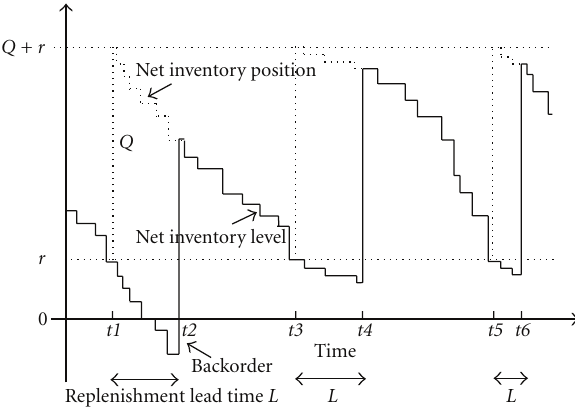
Figure 1: A standard ( Q , r ) inventory policy without supply disrup-